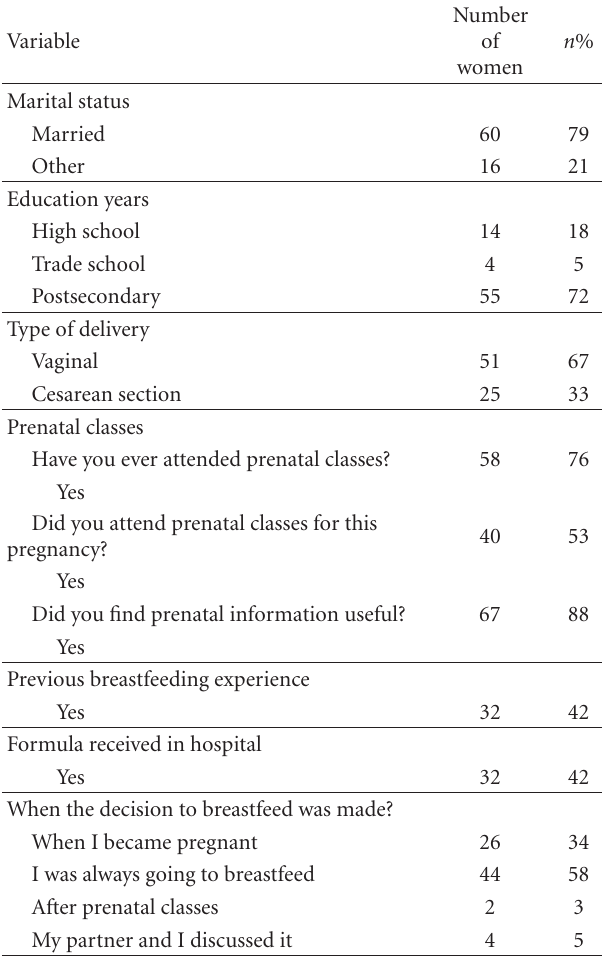
Table 3: Sample characteristics N =